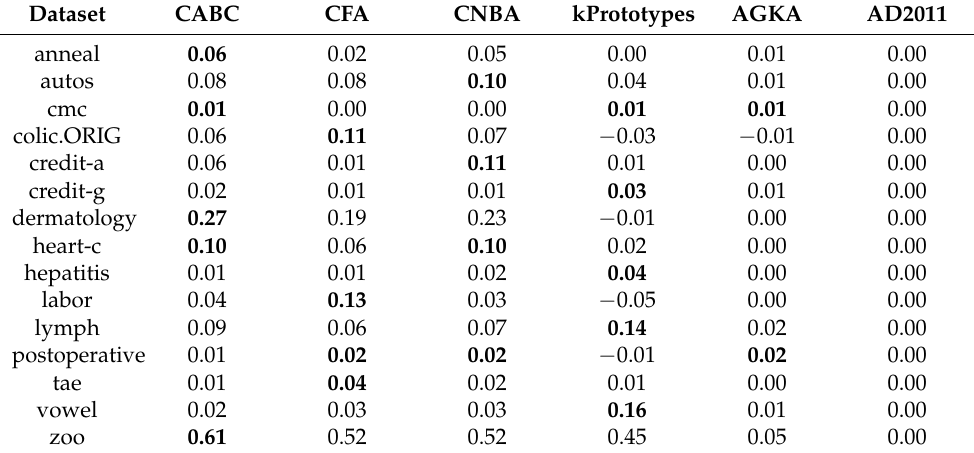
Table 8. Performance results according to adjusted Rand index of CABC, CFA and CNBA with respect to other algorithms.